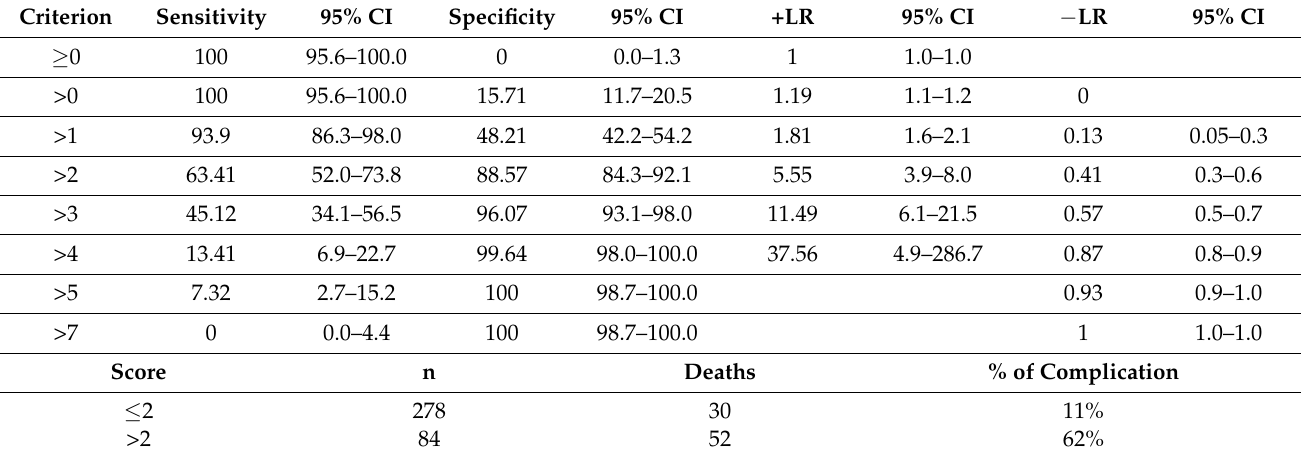
Table 8. Multivariate Cox regression on factors predicting complications.